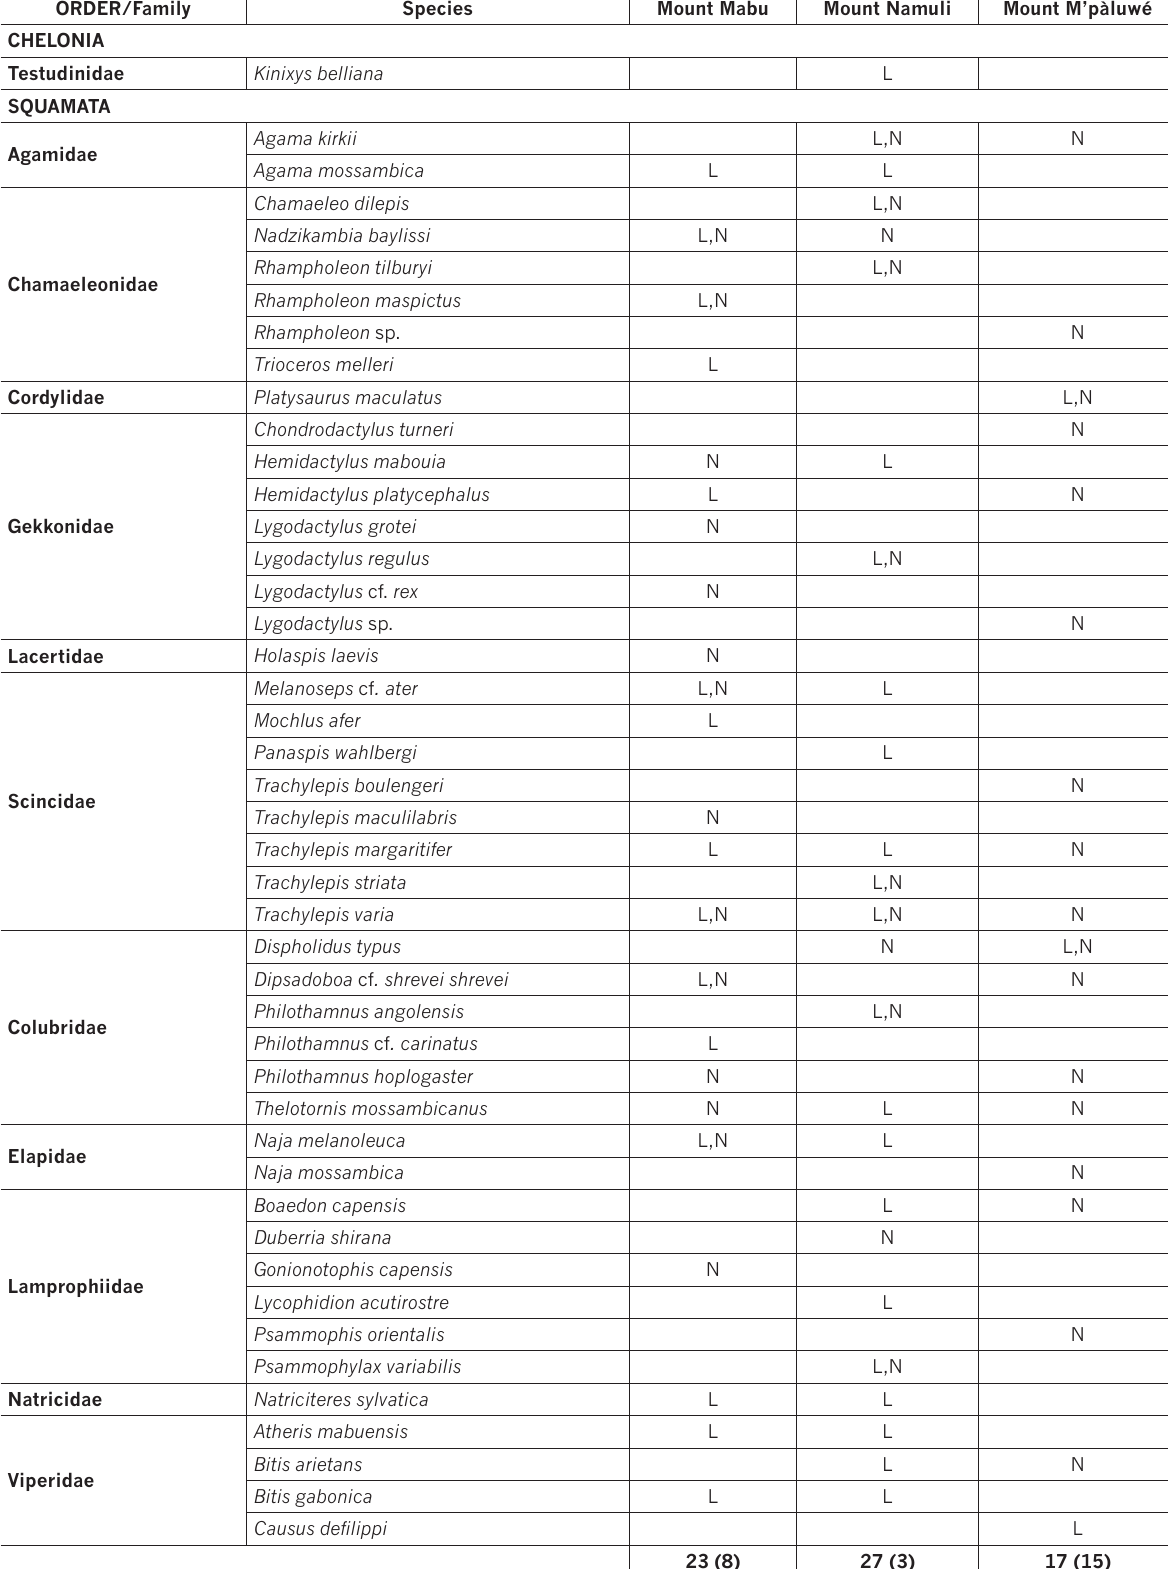
Table 3. Updated species lists for reptiles based on historical records as well as data from the current surveys. Parentheses in the totals given denote the number of new species recorded during the current surveys. Literature records are indicated with L and new records with